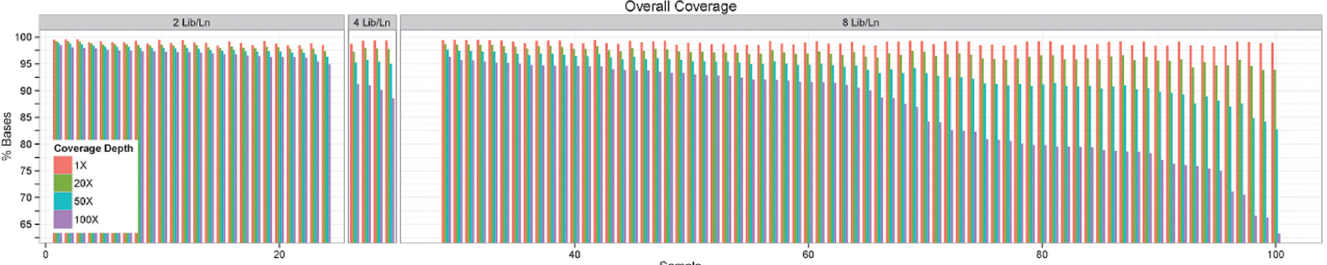
Fig 2. Depth and Breadth of On-Target Coverage of the 100 Lung Cancer Samples. Shown for each tumor specimen is the percentage of targeted bases covered at given coverage depth (1x, 20x, 50x, 100x) and sequenced under different lane settings in the HiSeq 2000 instrument (2, 4, and 8 DNA libraries per lane,